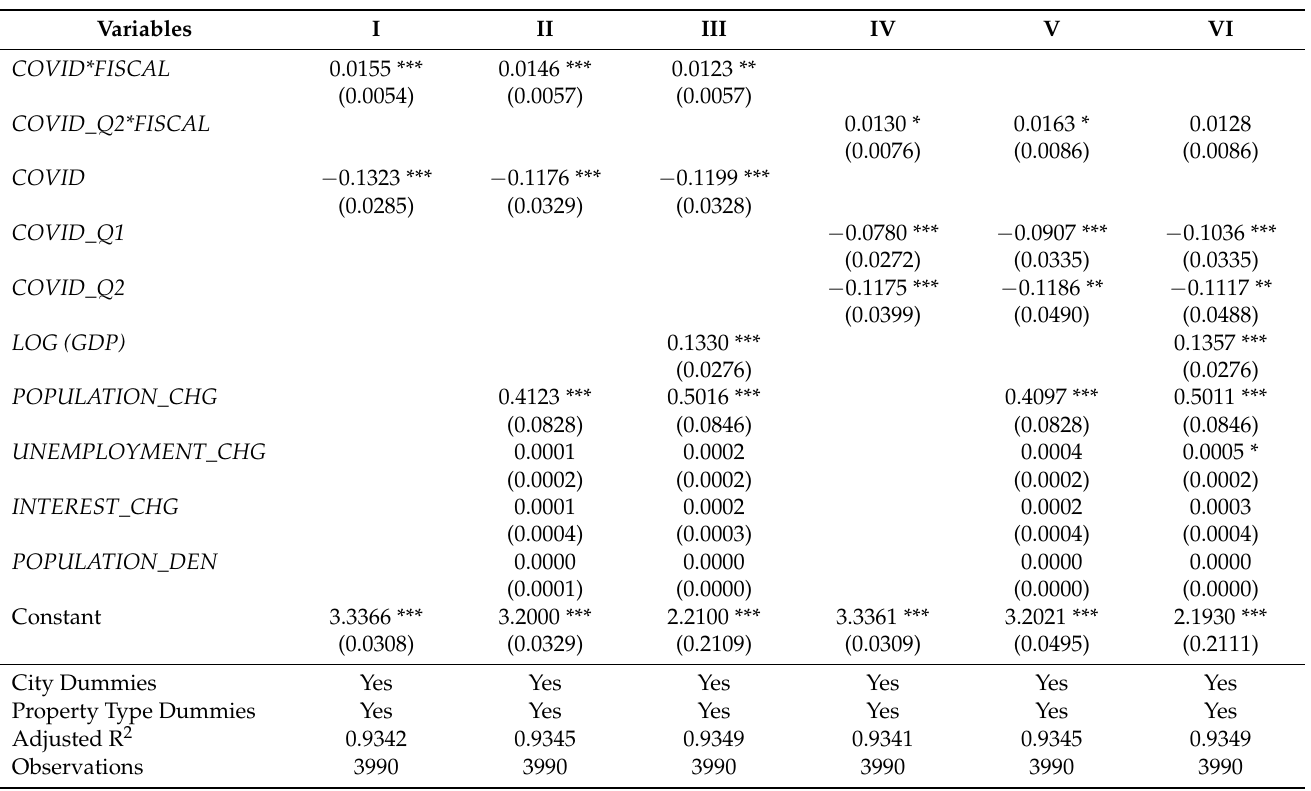
Table 7. Additional Analysis on Government Policy Responses. This table presents the OLS regression estimation results of testing the impact of the COVID-19 pandemic and government policy responses on commercial real estate rent. The dependent variable is LOG (RENT) , the natural logarithm of rent for the specific city and property type. The independent variables of interest are the interaction terms of COVID (COVID_Q2) and FISCAL . All variables are described in Appendix A. The standard errors are reported in parentheses. ***, **, and * denote significance of the t-statistics at the <1%, 5% and 10% levels,